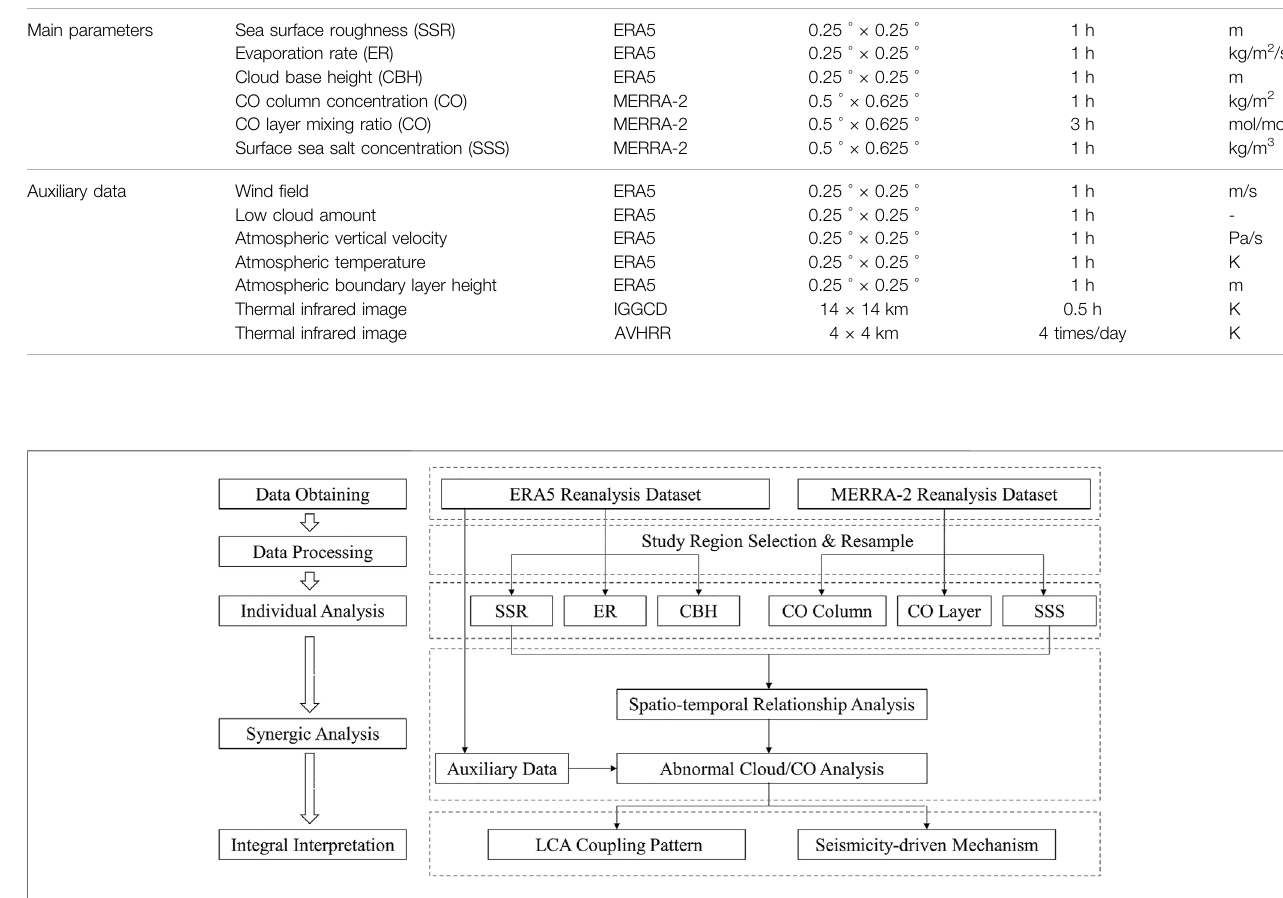
FIGURE 3 | The overall technical routine of this